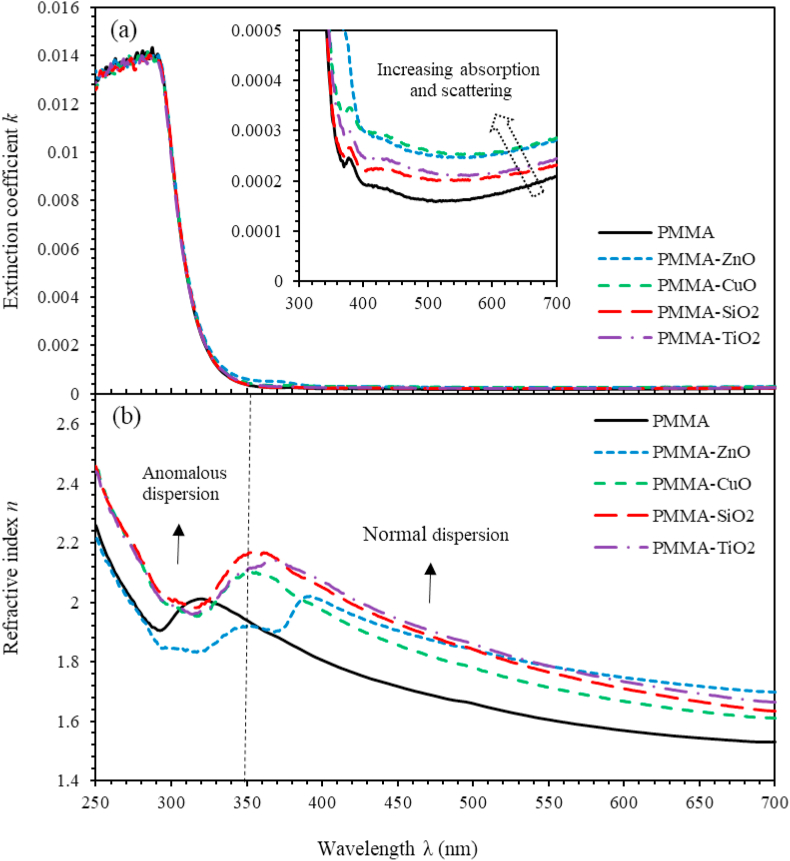
The two key optical parameters, namely, (a) Extinction coefficient, k and (b) Refractive index, n of the PMMA and PMMA incorporated with ZnO, CuO, SiO2 and TiO2 NPs nanocomposites thin films versus the wavelength of incident light.